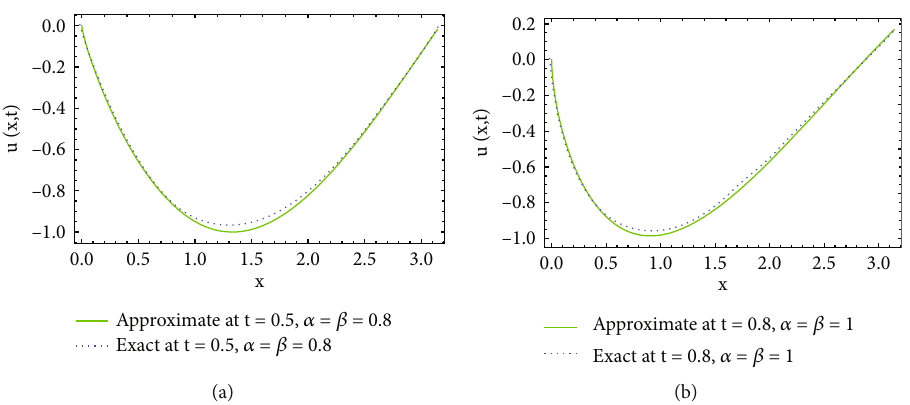
Figure 8: 2D solution plots of Example 4 obtained by the present method in comparison with the exact solutions for di ff erent values of fractional orders α and β